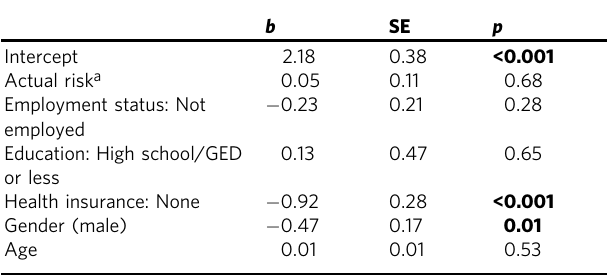
Table 3 Generalized linear models predicting the association between perception of risk of COVID-19 to one ’ s family/ friends.